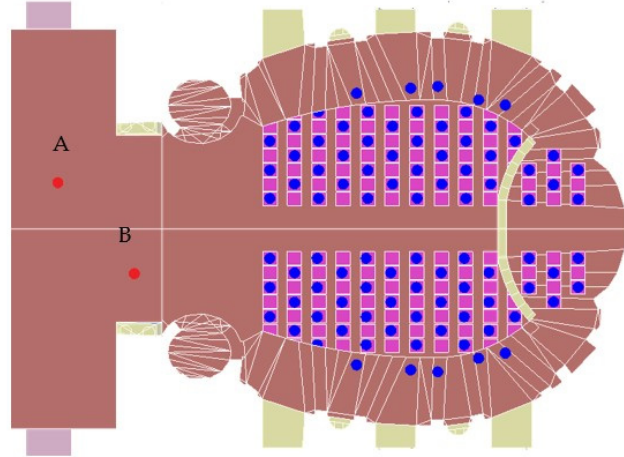
Figure 7. Plan of sound source positions (red points) and 106 receiver positions (blue points).